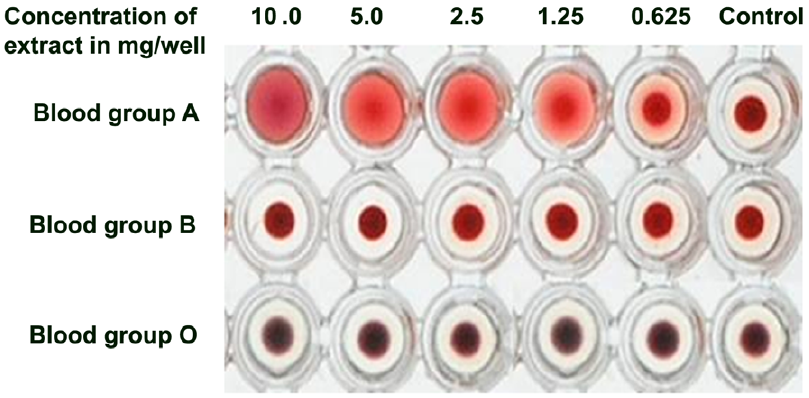
Figure 1. Hemagglutination activity of Crude extracts from Aeglemarmelos . Aegle marmelos fruit showed hemagglutinating activity on blood-group-A at 5 mg/well, but on group-O and group-B erythrocytes hemagglutinating activity was not seen even at 10 mg/well. PBS alone was added in control well.